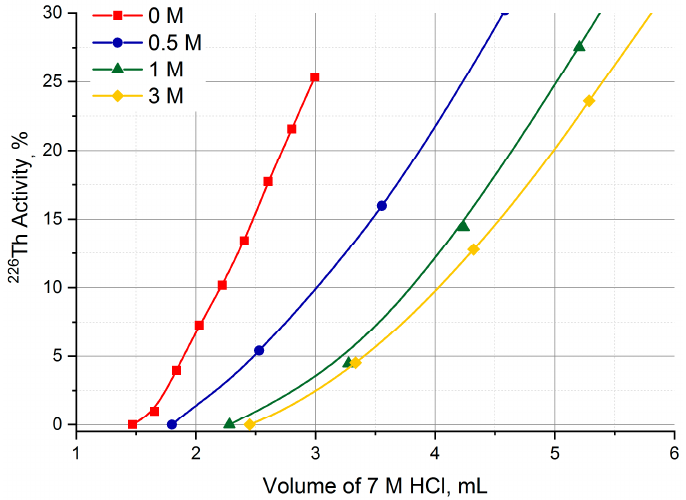
Figure 9. Choice of HNO 3 concentration for the pre-treatment of UTEVA resin column.